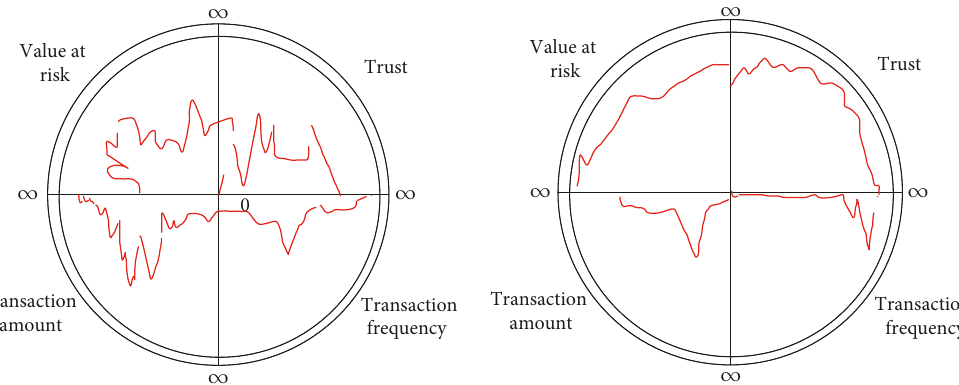
Figure 8: Comparison of transaction trust before and after empowerment.